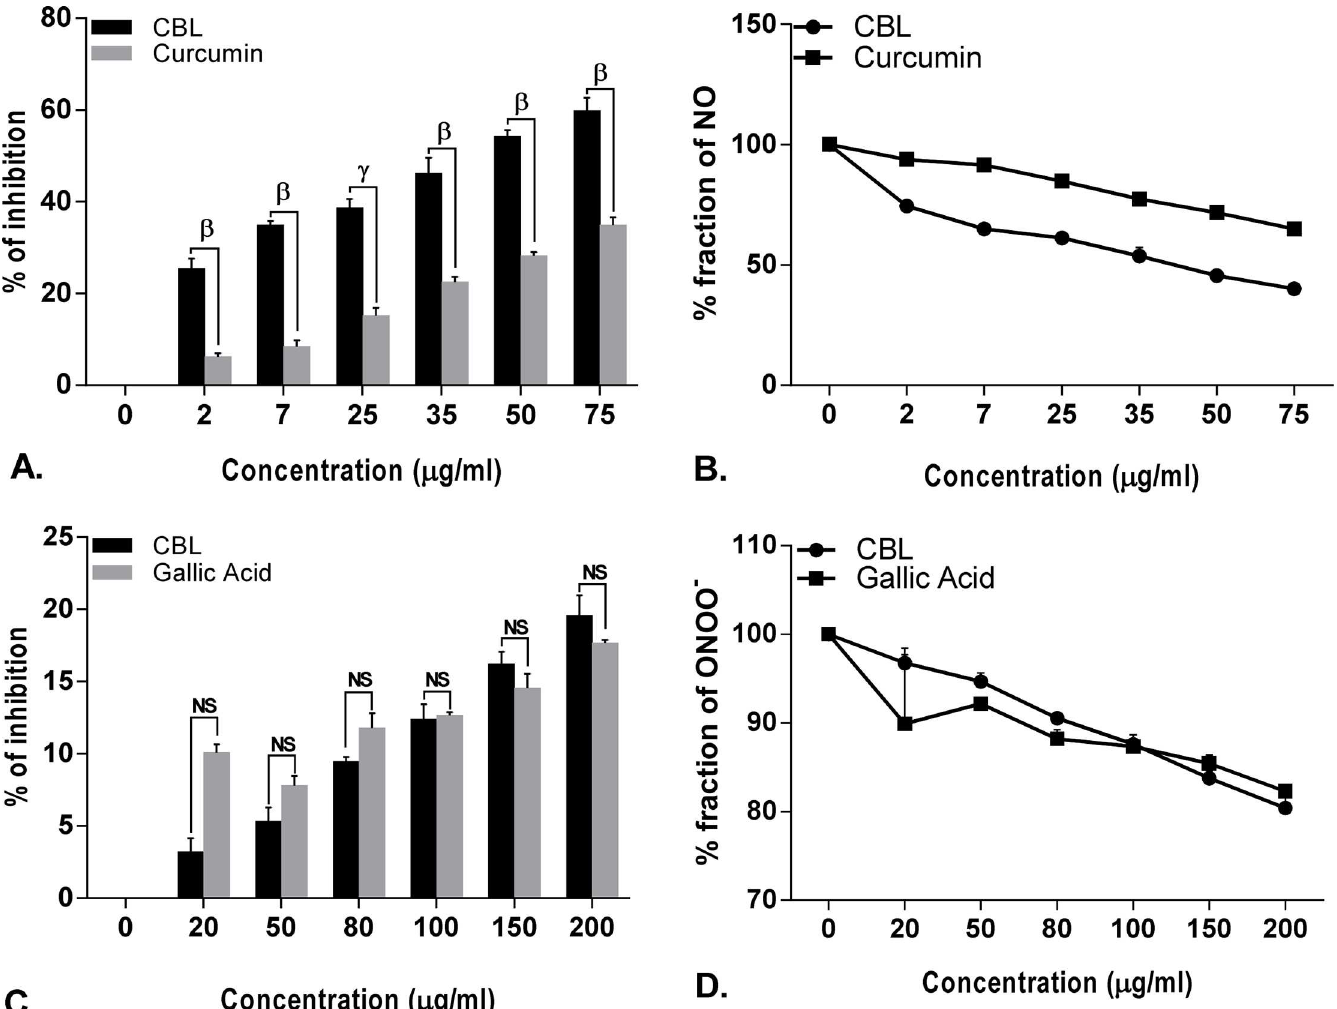
Fig 6. Antioxidant activity of Croton bonplandianus . (A) % inhibition of Peroxynitrite (OONO - ) Vs standard gallic acid; (B) depicts unneutralized Peroxynitrite (OONO - ); (C) Total reducing power activity.Data expressed as mean ± S.D (n = 6). α p < 0.05; β p < 0.01; γ p < 0.001; NS-Non significant when compared with